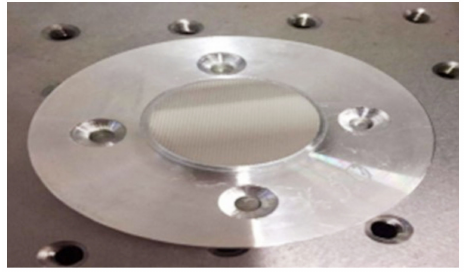
Figure 6. Photograph of the pressing stamper with a prismatic diopter of 5.0 ∆ .